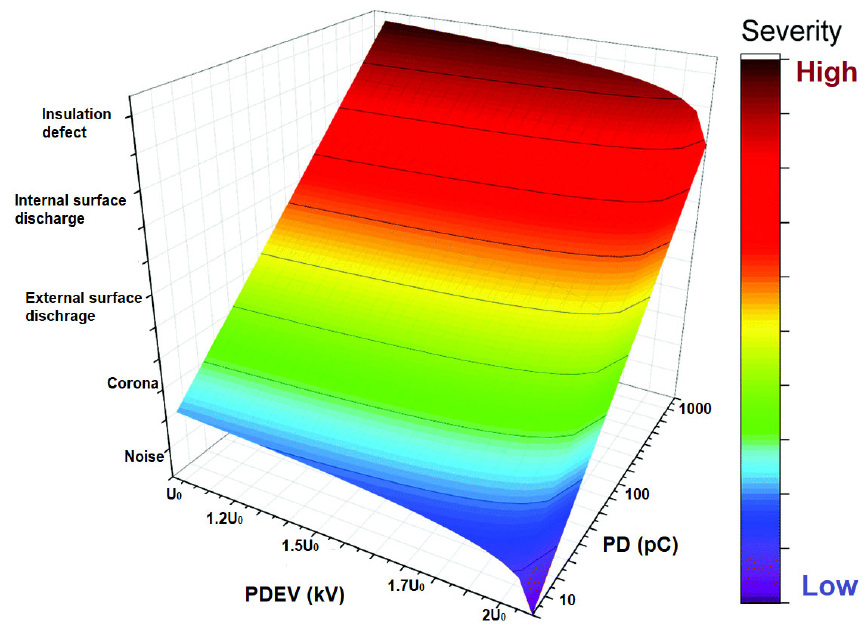
Figure 5. Illustration of PD severity based on PD magnitude (pC), PDEV, and type of defect (detected by PRPD).